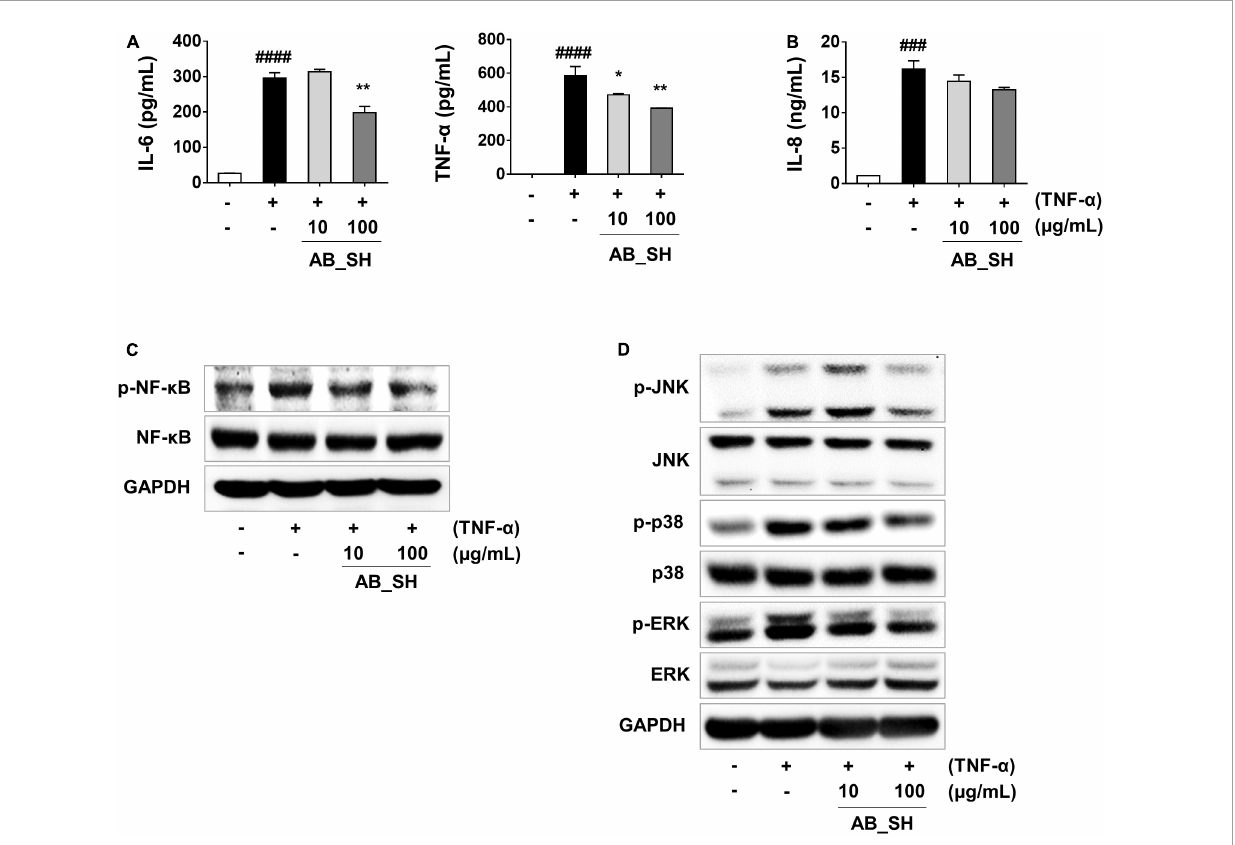
FIGURE3 Anti-inflammatory effect of AB_SH on cytokine production and NF- κ B/MAPK signaling in TNF- α -stimulated ARPE-19 cells. ARPE-19 cells were pre-treated with AB_SH for 1 h and then stimulated with 50 ng/mL TNF- α for 24 h. The levels of cytokines and chemokines were measured by ELISA. (A) Levels of the cytokines IL-6 and TNF- α , and (B) level of the chemokine IL-8. Effect of AB_SH on (C) NF- κ B and (D) MAPK signaling pathways. The cells were pre-treated with AB_SH for 1 h and then stimulated with 50 ng/mL TNF- α for 30 min. The cell lysates were subjected to western blot analysis. GAPDH was used as a loading control. The values represent the mean ± SD of three independent experiments. ### p < 0.001, #### p < 0.0001 compared with the control. * p < 0.05 and ** p < 0.01 compared with the TNF- α -treated control, respectively.